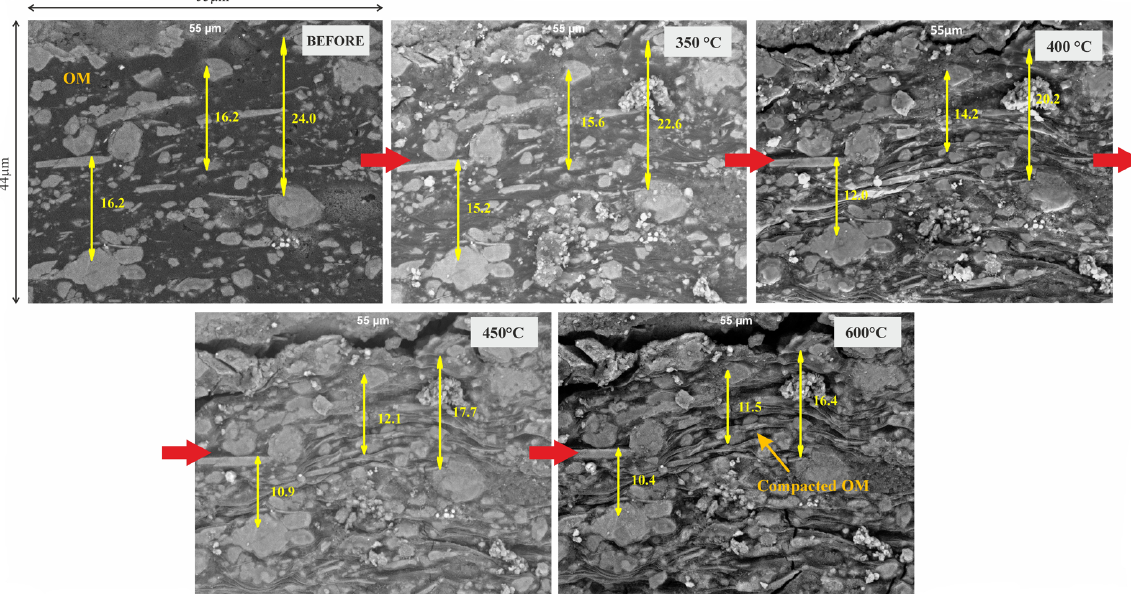
Figure 7. BIB-SEM images of sample Ch-46t before heating and at T = 350–600 ◦ C illustrating the OM shrinkage.